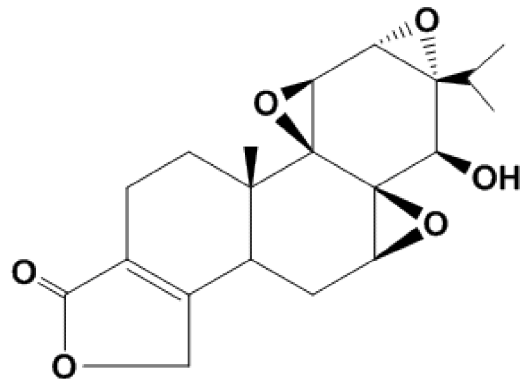
Figure 1. The chemical structure of